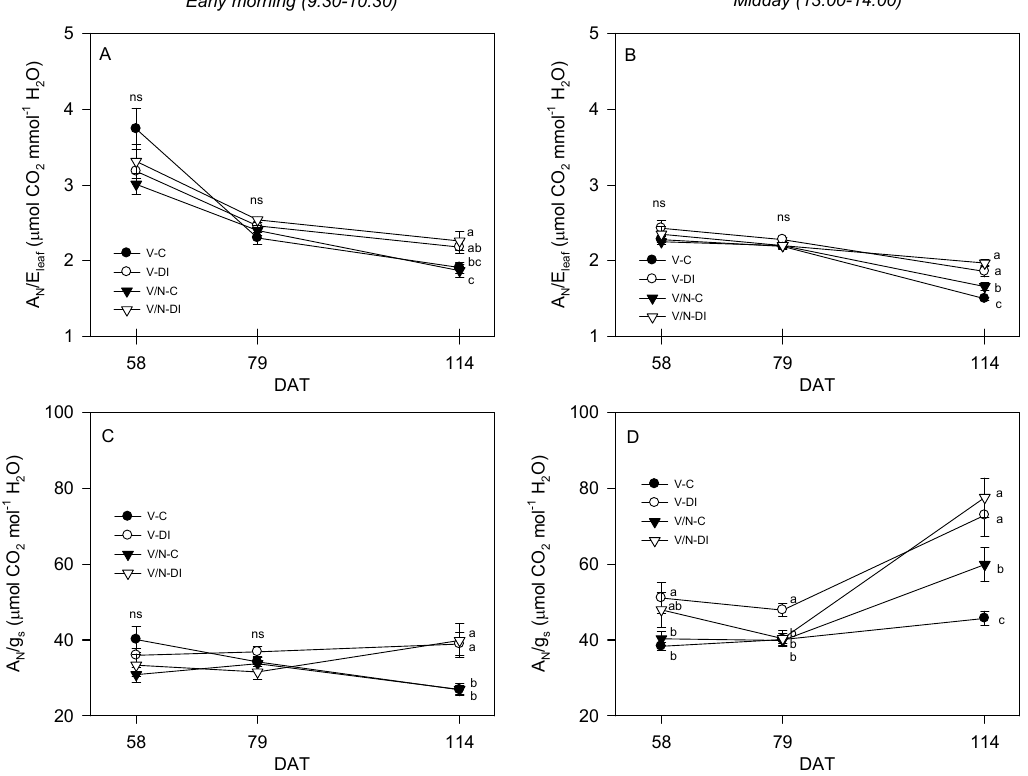
Figure 4. Instantaneous water use e ffi ciency (A N / E leaf ) ( A , B ) and intrinsic water use e ffi ciency (A N / g s ) ( C , D ) measured at two representative day times (early morning, midday) in the ungrafted pepper plants (cultivar ‘Maestral’, V) and the plants grafted onto NIBER ® (V / N) grown under well-irrigated (C) and deficit-irrigated (DI) conditions. Measurements were taken on 58, 79, and 114 days after transplanting (DAT). Data are the mean values for n = 9 ± SE. For each studied time, di ff erent letters indicate di ff erences at p ≤ 0.05 (LSD test). n.s. indicate no significant difference.